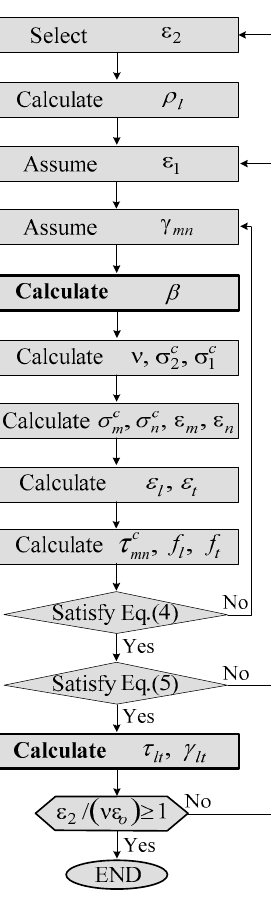
Figure 4. Calculation procedure.